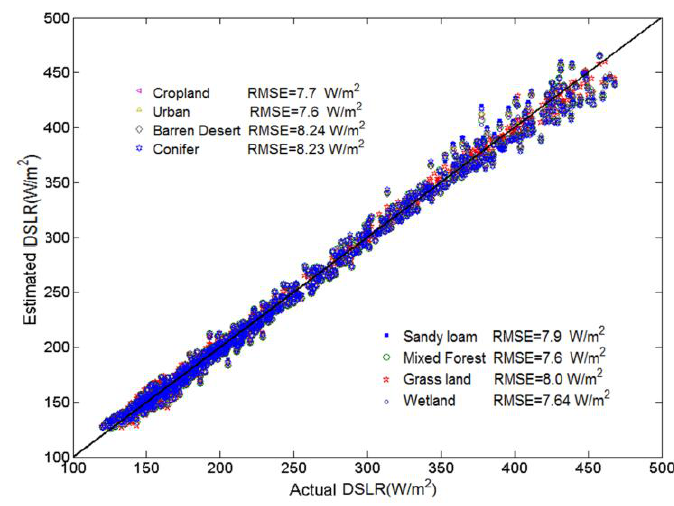
Figure 8. Comparisons of the actual downwelling surface longwave radiation with estimations using the proposed model with the training dataset and VZA = 0°, surface altitude z = 0 km and AOD less than 1.0.